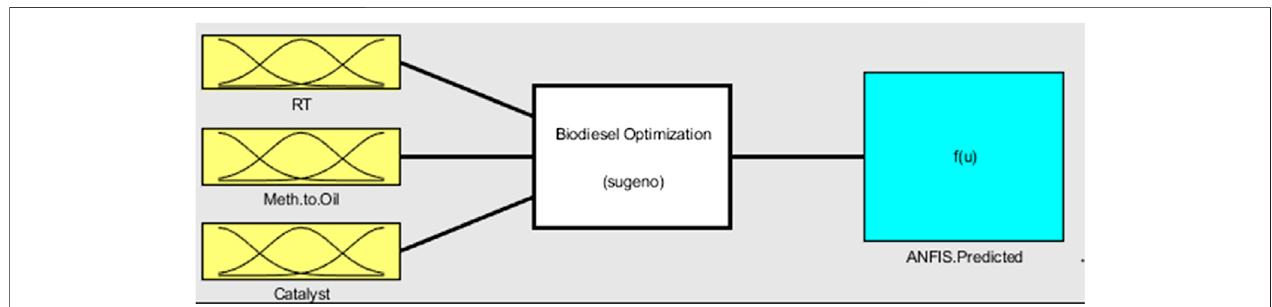
FIGURE 11 | Architectures for